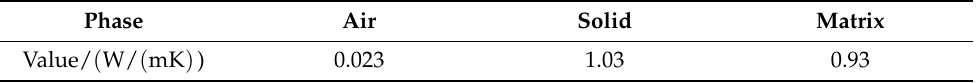
Table 1. Thermal conductivity coefficients of compositional phases within RVE 1